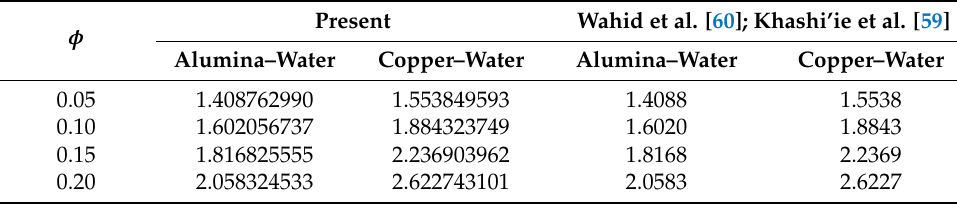
Table 5. Values of Re 1/2 x C f when N = Rd = Du = Sc = Sr = λ = 0 and Bi → ∞